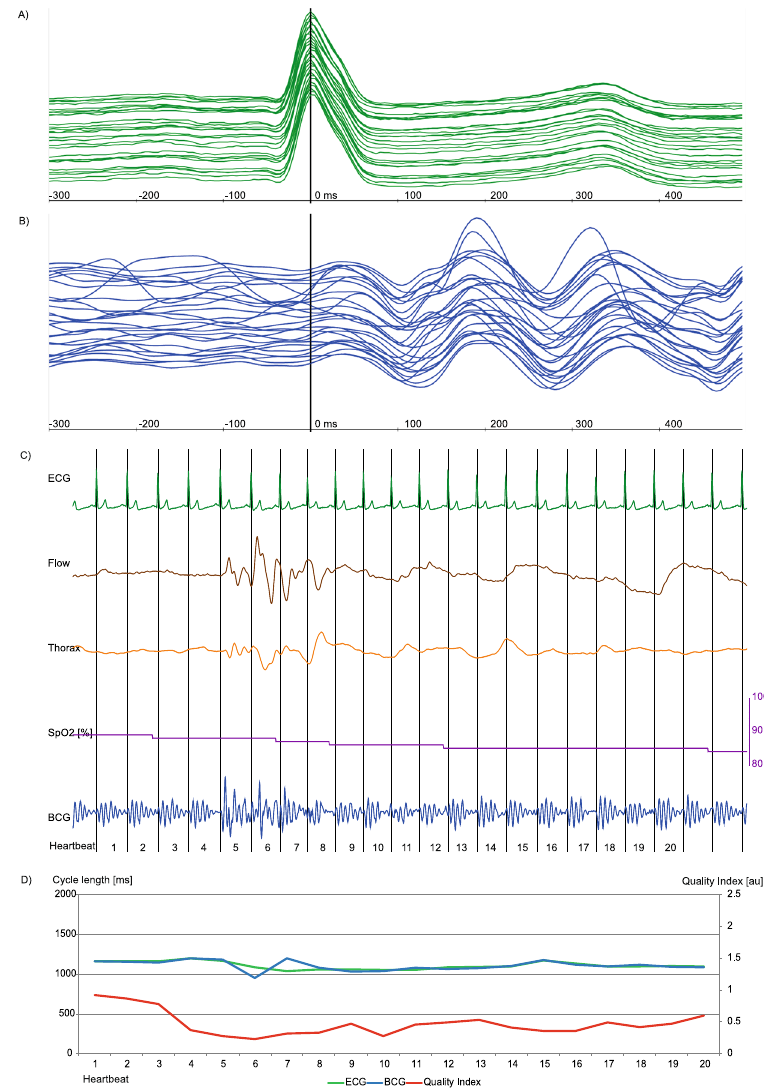
Figure 6. Episode of central sleeping apnea with good signal correlation. Arousal and the following deep respiration manoeuvres are associated with increased muscular tone and subsequently lead to decreased BCG signal detection in comparison to the simultaneously recorded ECG with slight cycle length mismatch and decreased QI. Each signal is visualized by a unique colour: ECG (green), BCG (blue), Airflow (brown), thorax movement (orange), oxygen saturation (purple) and QI (red). ( A , B ) Plot of 23 consecutive heartbeats. The upper-most signal is the start, the bottom-most is the end of the sequence. The signals are synchronized and the maximum of R peak in ECG signal is situated at 0 ms. A: In the ECG signal a sinus rhythm can be identified. ( B ) The BCG shows acceptable overlap in amplitude height and chronological sequence. In contrast to the BCG during obstructive sleeping apnea (Fig. 5) the signal is more harmonic with a slight superposition during deeper respiration manoeuvres. ( C ) Plot with simultaneously recorded ECG (green), air flow (brown), thoracic (orange) movement amplitude, oxygen saturation (purple) and BCG (blue) deflection. In the apnea phase, there is nearly no flow and no thoracic- or abdominal-movement. With decreasing oxygen saturation, thoracic- and abdominal- movement are increasing leading to an arousal correlated reaction with increased muscular tone and superposition of the mechanic heart activity in the recorded BCG signal. A continuous BCG measurement is feasible. But signal analysis is hampered in beats 5–8 showing moderate signal correlation indicated by a lower